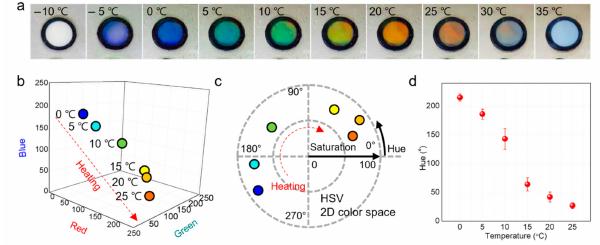
Figure 2. Color response of the HPC colorimetric sensor. ( a ) Photographs showing the HPC colori- metric sensor by increase in temperature. Color response of the colorimetric sensor as a function of temperature depicted in the ( b ) RGB color space and ( c , d ) HSV color space.